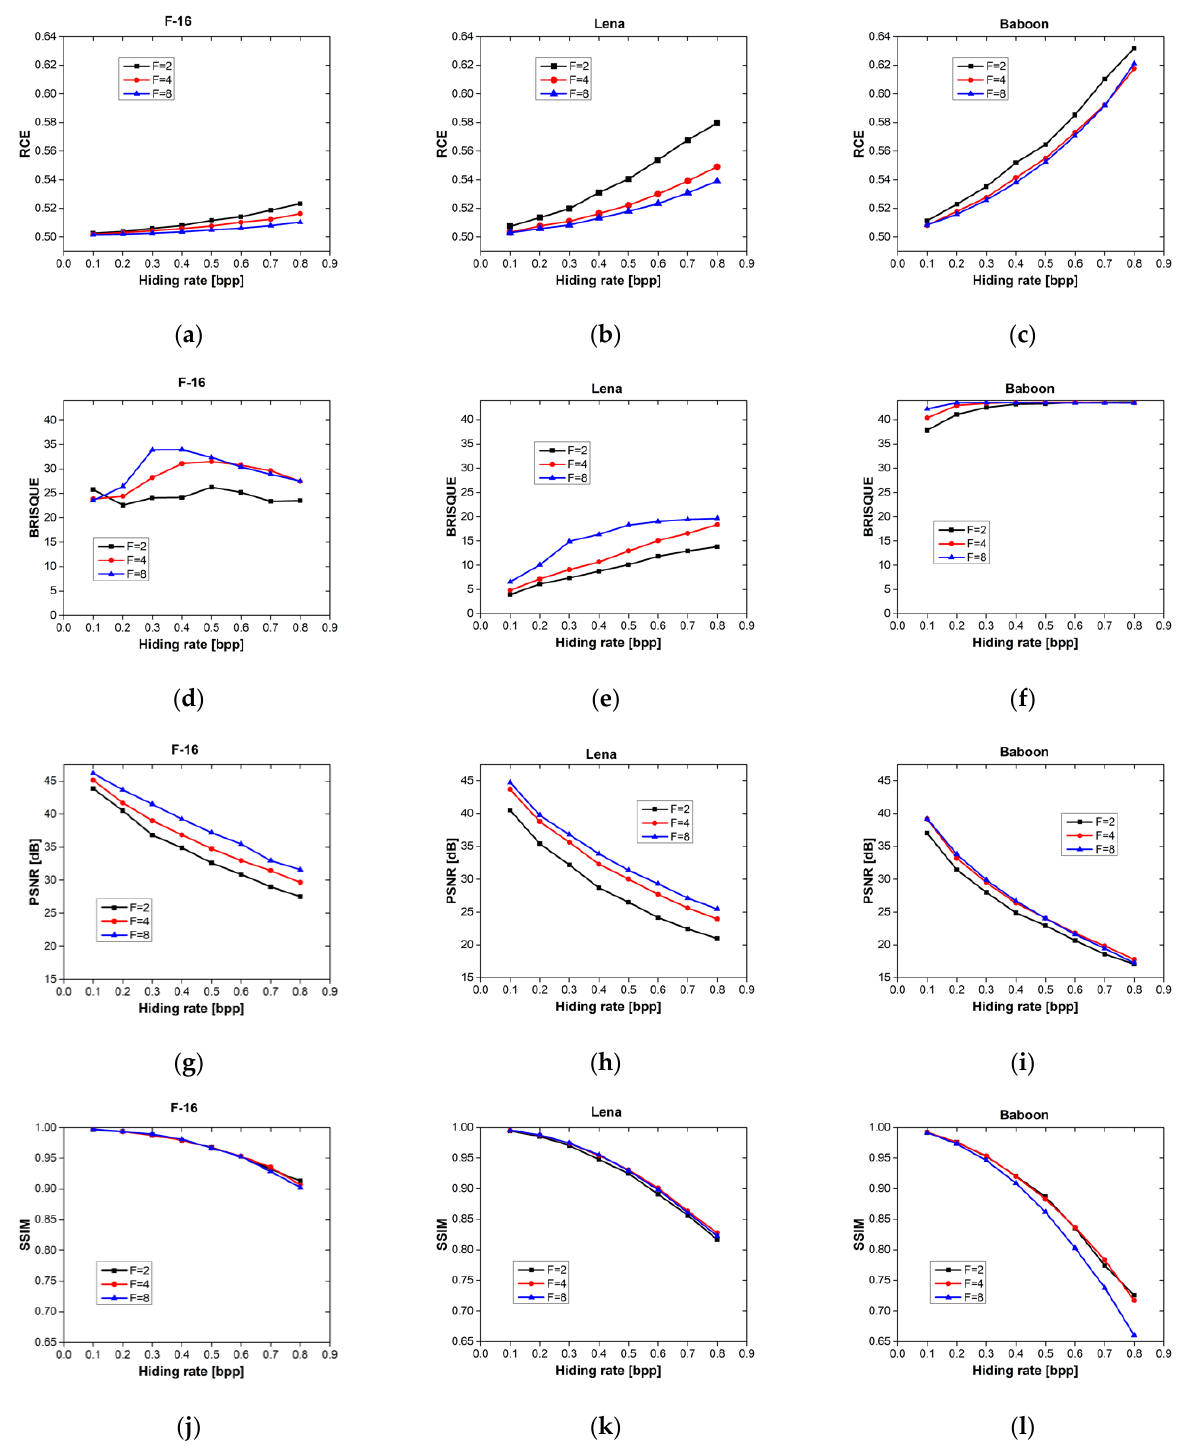
Figure 11. Assessment metrics with different hiding rates for F-16, Lena, and Baboon images: RCE